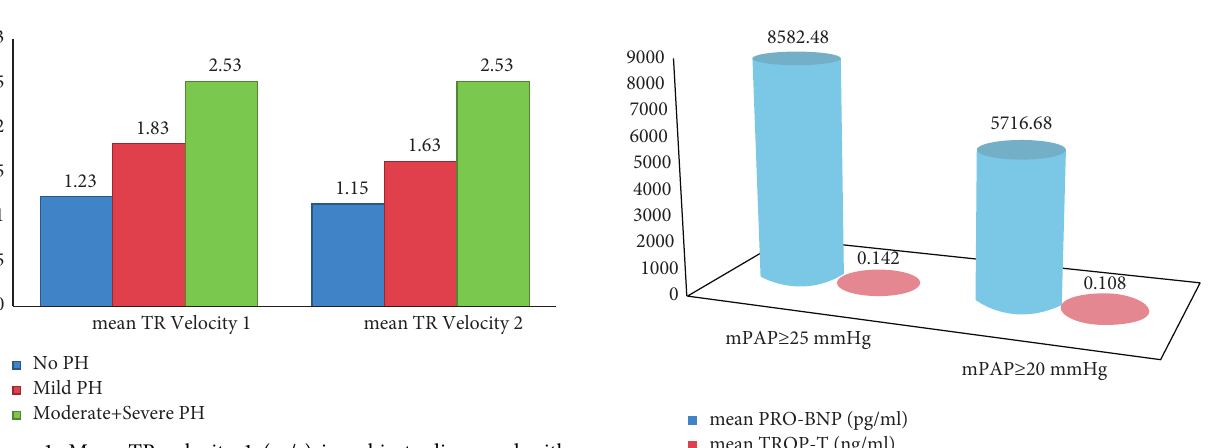
Figure 1: Mean TR velocity 1 (m/s) in subjects diagnosed with older definition and mean TR velocity 2 (m/s) in subjects diagnosed with newer definition.